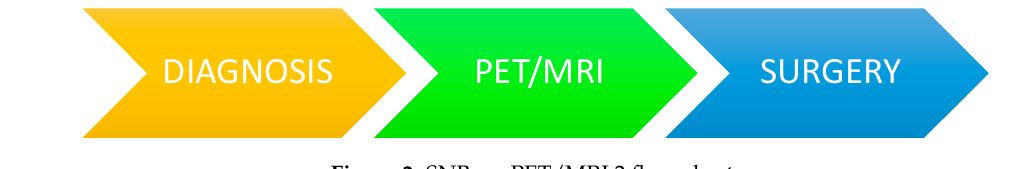
Figure 2. SNB vs. PET/MRI 2 flow-chart.